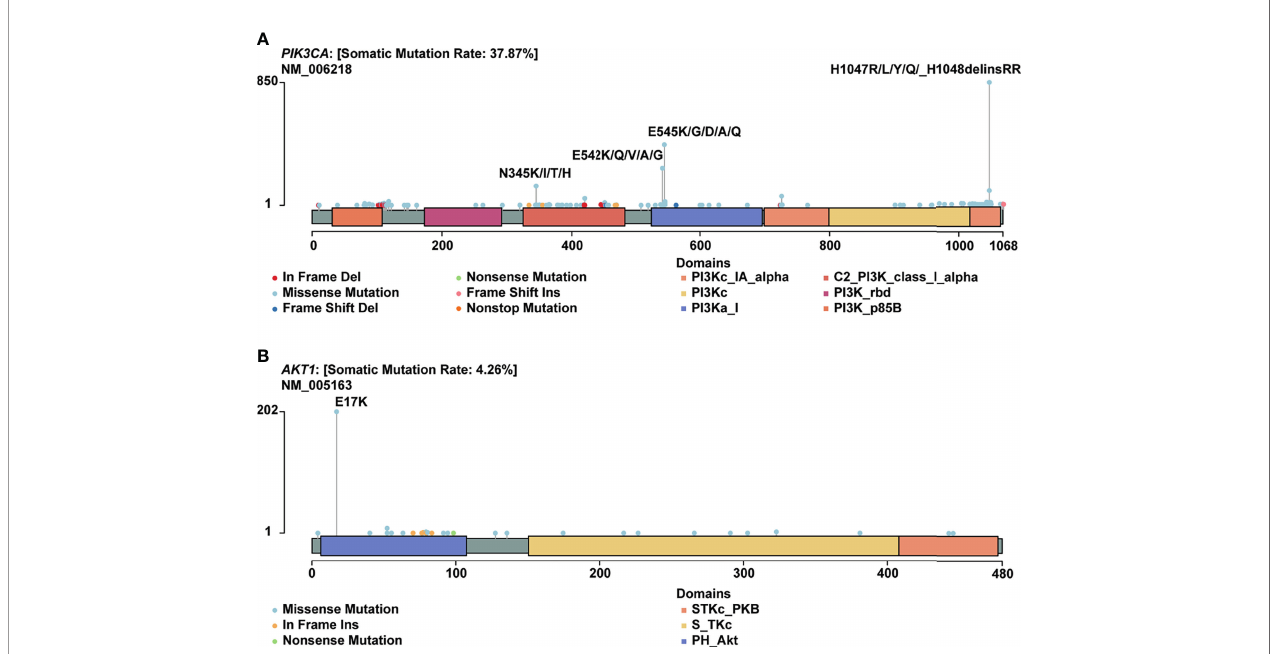
FIGURE 3 | Mutational spectrum of speci fi c genes. (A) Mutations across the PIK3CA gene, no corresponding neoantigen for E542K; (B) Mutations across the AKT1